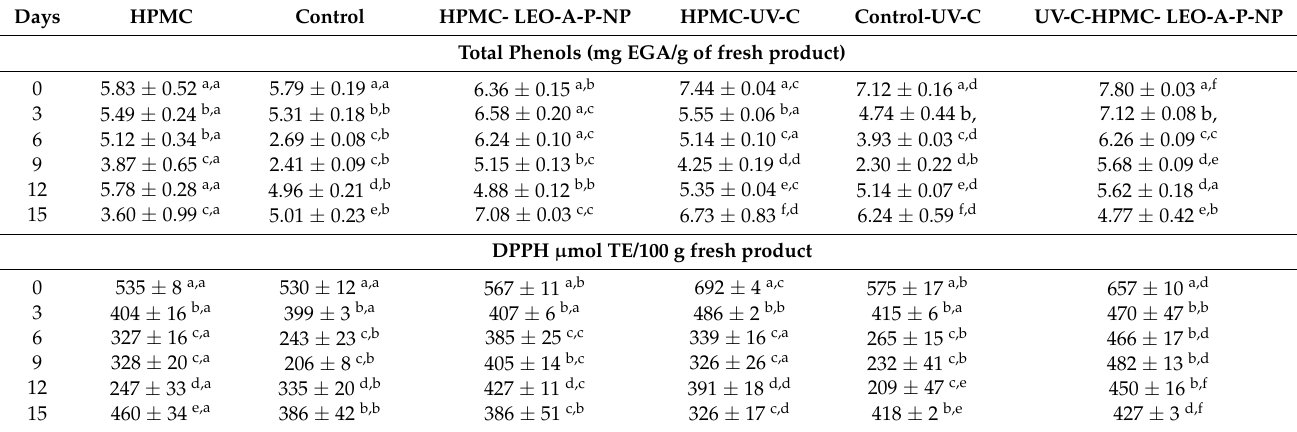
Different letters to the left represent statistically significant differences ( p ≤ 0.05) in storage time, and those to the right represent differences in